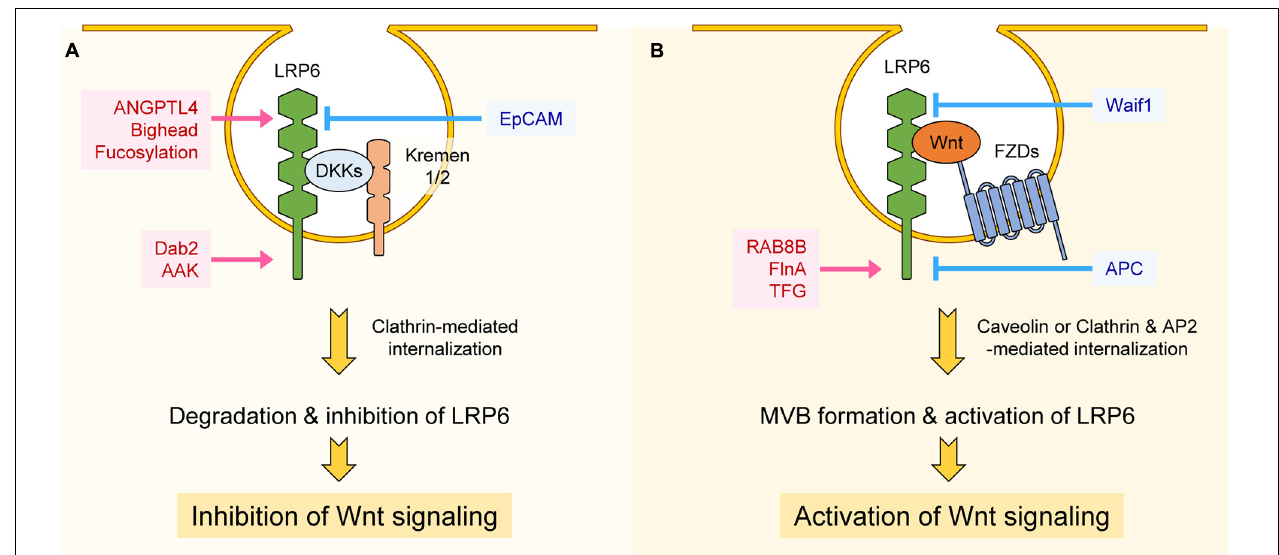
FIGURE 3 | Regulation of LRP6 internalization. (A) Interaction between LRP6, DKKs, and Kremen1/2 promotes clathrin-mediated internalization, resulting in degradation or inhibition of LRP6. ANGPTL4, Bighead, and fucosylation of LRP6 promotes internalization of LRP6 at the extracellular level, thereby inhibiting LRP6 function and Wnt/ β -catenin signaling. Dab2 and AAK function at the intracellular level and promote clathrin-mediated internalization of LRP6, resulting in Wnt/ β -catenin signaling suppression. On the other hand, EpCAM inhibits LRP6-DKK-Kremen1/2 complex formation, resulting in Wnt signaling activation. (B) Interaction among LRP6, FZDs, and Wnt promotes caveolin-mediated internalization, resulting in LRP6 activation and MVB formation. RAB8B, FinA, and TFG promote Wnt3a-mediated internalization of LRP6 and Wnt/ β -catenin signaling at the intracellular level. However, Waif1 compromises Wnt-LRP6 interaction and inhibits Wnt/ β -catenin signaling. APC inhibits Clathrin and AP2-mediated internalization of LRP6 at the intracellular level, resulting in suppression of Wnt/ β -catenin